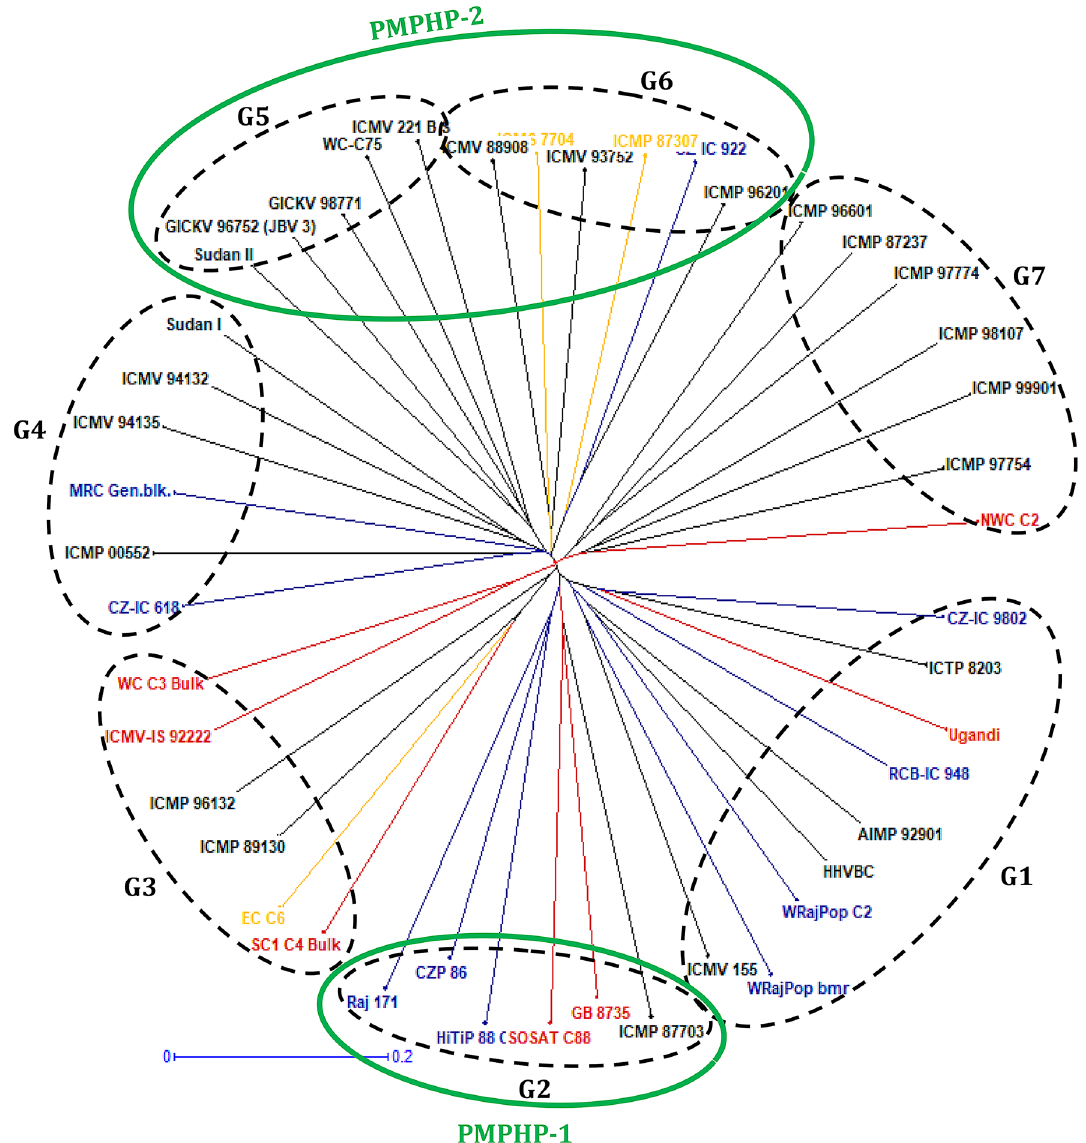
Figure 1. Unweighted Neighbor-joining tree of 45 pearl millet populations [10- As-As (Asian origin and Asian bred), 7 Af-Af (African origin and African bred), 3 (As × Af)-As {(Asian × African) origin and Asian bred} and 25 Af-As (African origin and Asian bred populations)] based on Modified Rogers distance (MRD) matrix using SSR markers. The blue color denotes As-As populations, the red color Af-Af, the yellow color (As × Af)-As and the black color Af-As populations. The G2 group represents PMPHP-1 (Pearl millet population heterotic pool- 1) and G5 + G6 represents PMPHP-2 (Pearl millet population heterotic was much higher than that of parental populations (2133 kg ha −1 ). Of the 91 population hybrids, 48 had positive SCA, and of these 12 had significant positive SCA. Hybrid GB 8735 × ICMP 87307 showed highest significant SCA effect while having H + gca × H + gca parental combination, followed by EC C6 × HHVBC with H − gca × L + gca combination. Fourteen population hybrids had H − gca × H + gca parental combination (Table 5). High posi- tive significant correlation (r = 0.70, P < 0.01) was found between GCA for grain yield and mean grain yield per se of the parental populations. In 21 marker-based hybrid groups, mean grain yield of the marker group varied from 1836 kg ha −1 (G3 × G7) to 2462 kg ha −1 (G2 × G6) (Table 6). Based on the performance of group crosses for grain yield, group cross G2 × G6 (2462 kg ha −1 ) had highest grain yield followed by G2 × G5 (2455 kg ha −1 ) and G4 × G5 (2342 kg ha −1 ). Magnitude of heterosis. The estimates of PMPH and PBPH for grain yield are presented in Table 7. Across the 91 population hybrids, PMPH ranged from − 21.7 to 62.1% with a mean of 6.4%, while PBPH ranged from − 32.5 to 43.0% with a mean of − 2.9%. Across 21 marker-based group crosses, PMPH ranged from − 8.5%